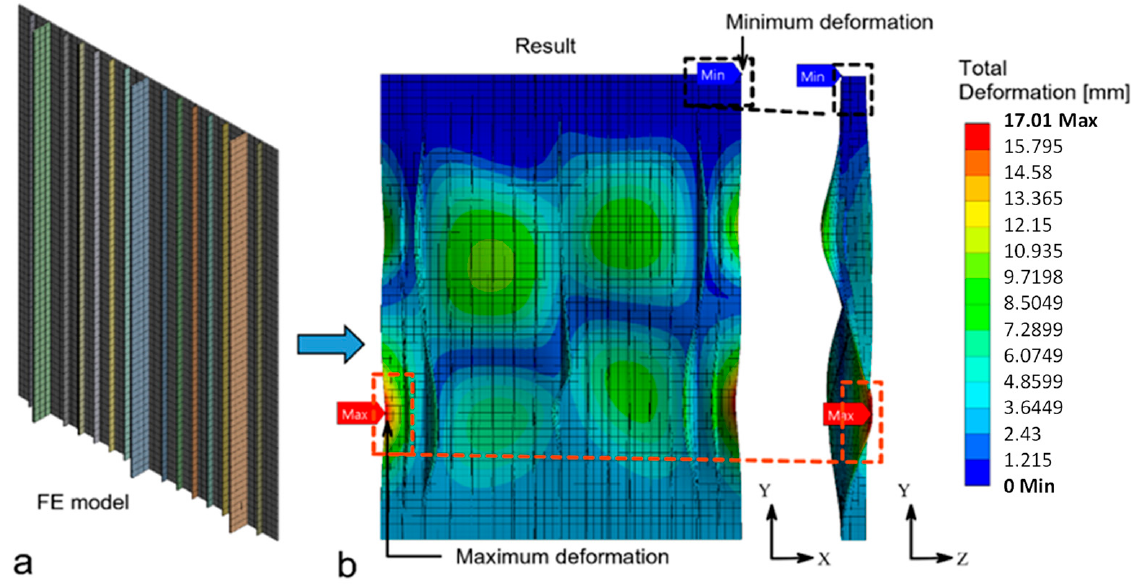
Figure 7. Typical finite element mesh on Specimen B. ( a ) FE model; ( b ) FE result with the deformation contour.